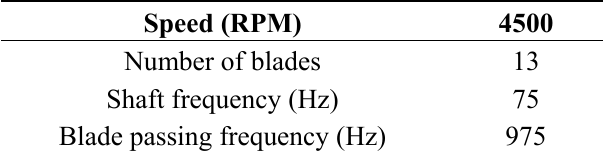
Table 1. Characteristic parameters for φ 800 test-rig.